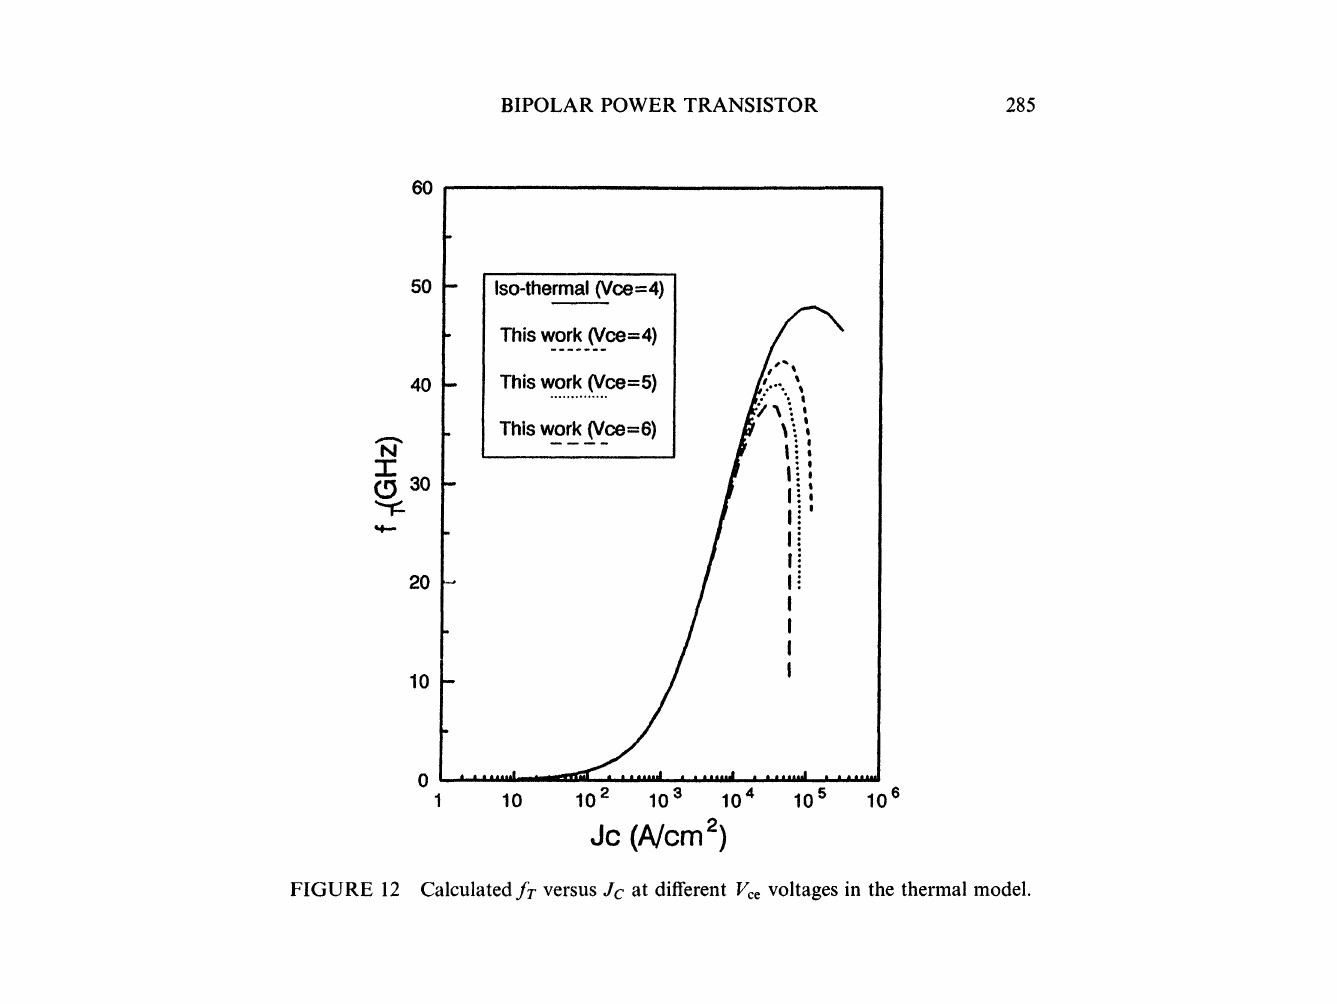
transit time "bc and results in smaller breakdown voltage